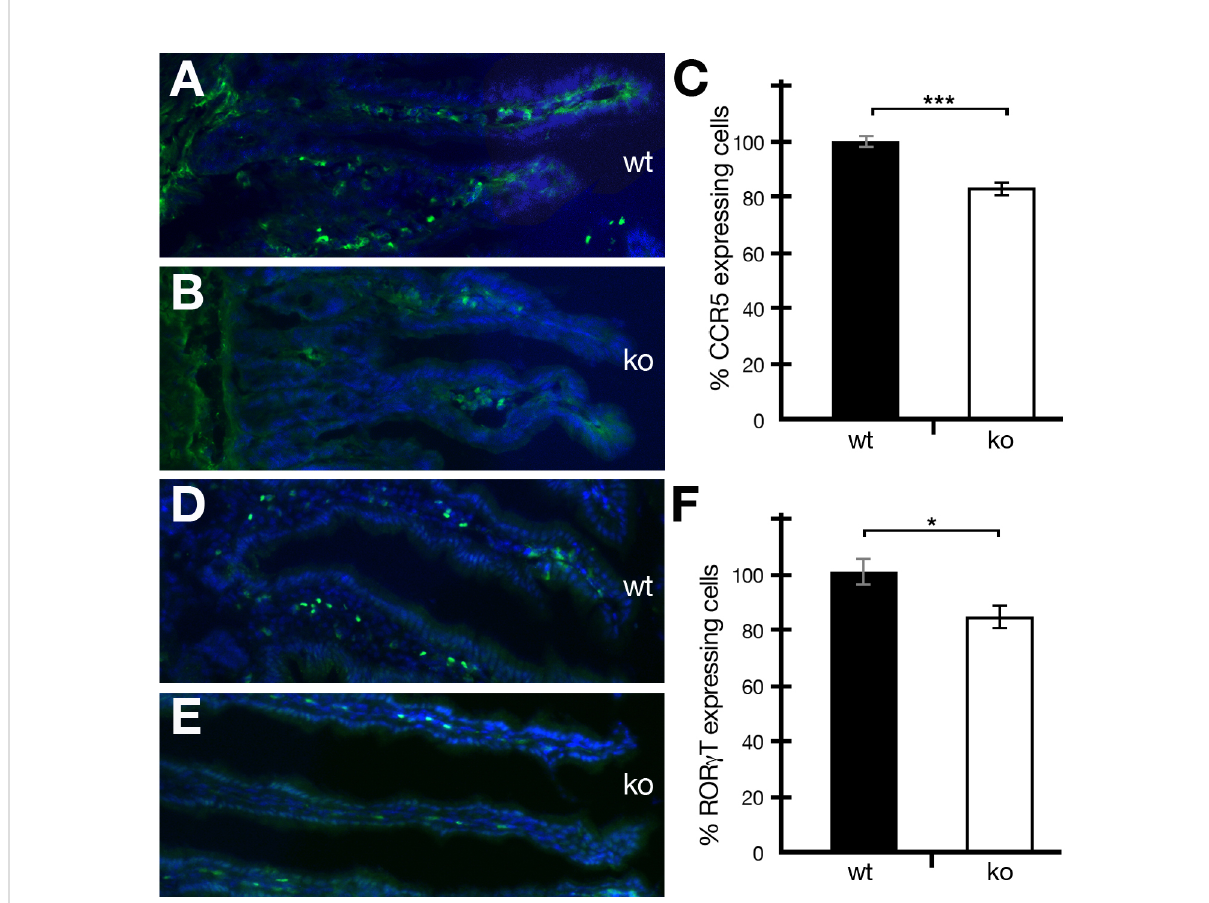
FIGURE 2 The absence of periostin reduces the number of CCR5- and ROR g T-expressing cells in the intestine of healthy mice. (A, B) Representative captures of wild-type (wt) (A) and periostin-de fi cient (ko) (B) small intestine sections showing immuno fl uorescence staining using the CCR5 antibody (green) and DAPI (blue). (C) The number of CCR5-expressing cells was normalized to 100% for wild-type mice (black histogram) and compared to the numbers in periostin-de fi cient mice (white histogram). (D, E) Representative captures of wild-type (wt) (D) and periostin- de fi cient (ko) (E) small intestine sections showing immuno fl uorescence staining using the ROR g T antibody (green) and DAPI (blue). (F) The number of ROR g T-expressing cells was normalized to 100% for wild type (black histogram) and compared to the numbers in periostin-de fi cient mice (white histogram). Please note that the differences are highly signi fi cant ( P < 0.001) in (C) and signi fi cant ( P < 0.05) in (F) . At least three animals and between fi ve and seven areas in at least three sections were used for determining the numbers for the graphs in (C, F) . *P < 0.05 and ***P <